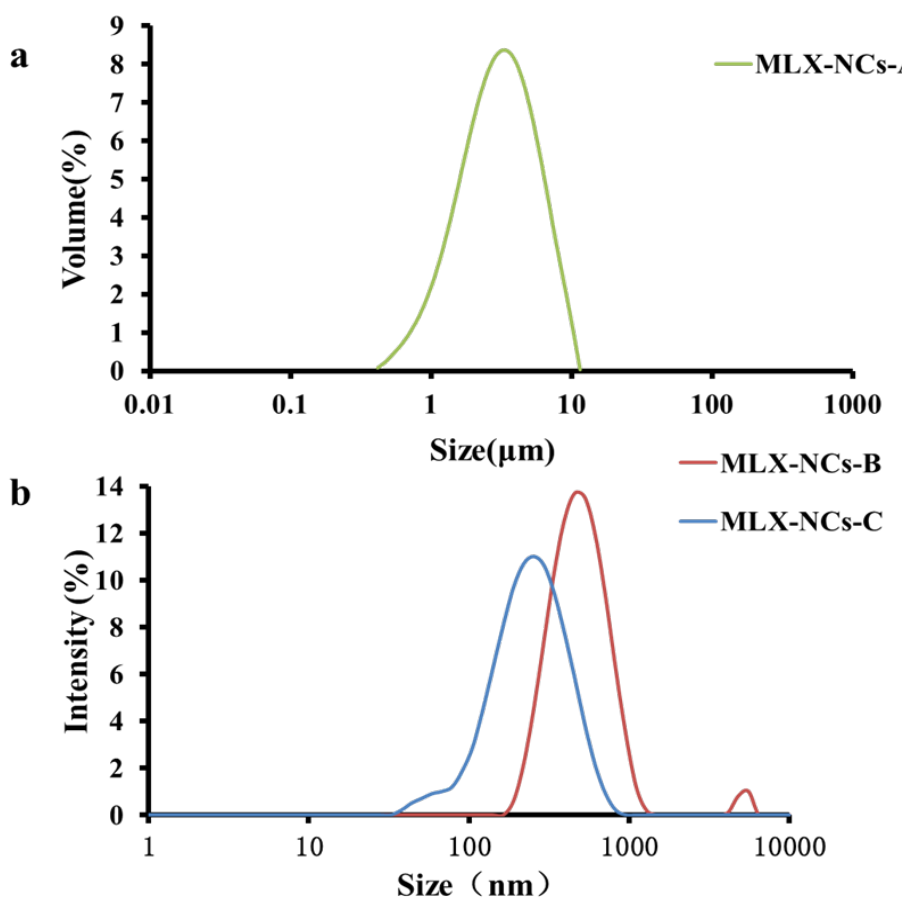
Figure 3. Particle size distributions of ( a ) MLX-NCs-A; ( b ) MLX-NCs-B and MLX-NCs-C.